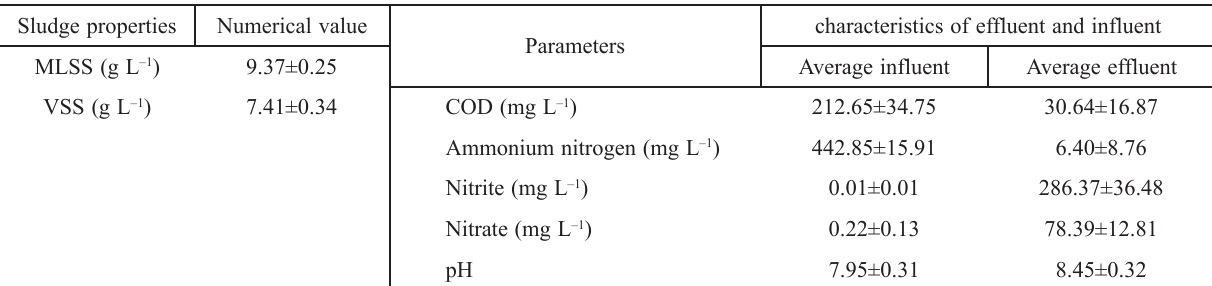
Table 1 – Characteristics of aerobic granular sludge, influent and effluent of wastewater